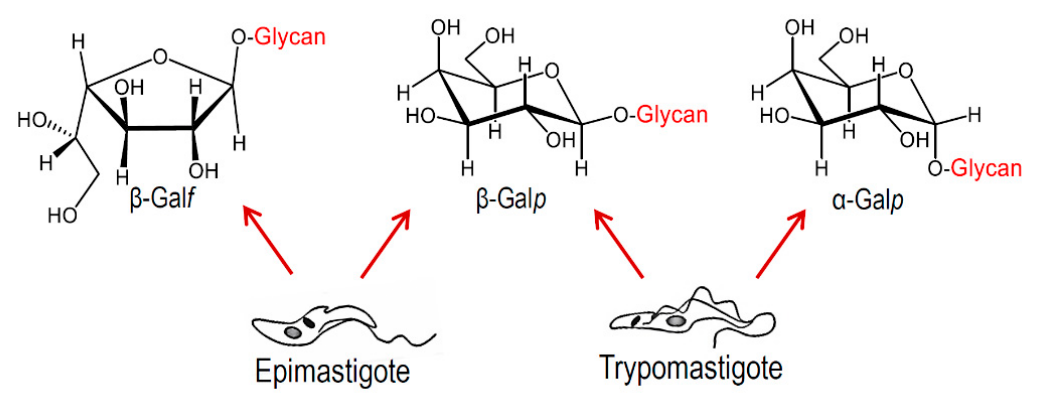
Figure 4. Configurations of Galactose (Gal) found in T. cruzi mucins.